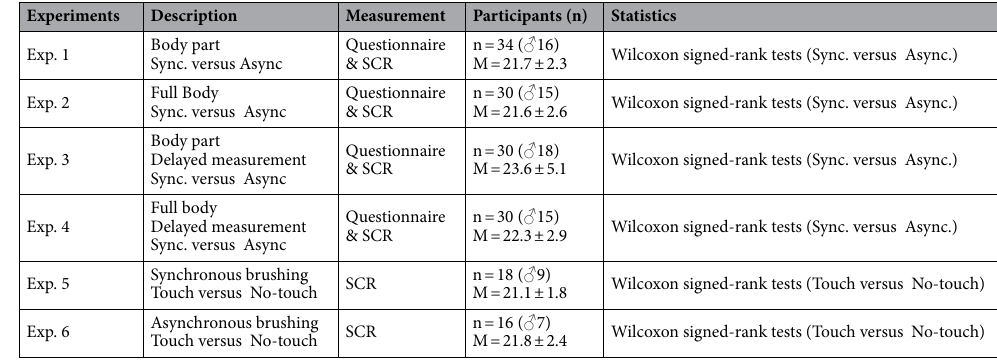
Table 1. Overview of Experiments.